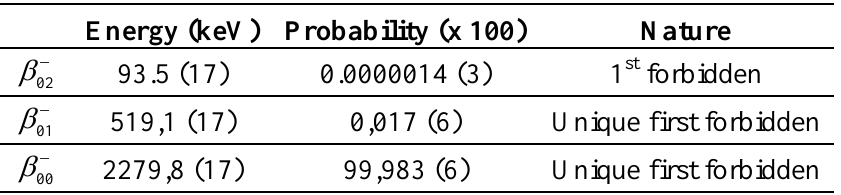
Table 2. Beta minus transitions of 90 Y